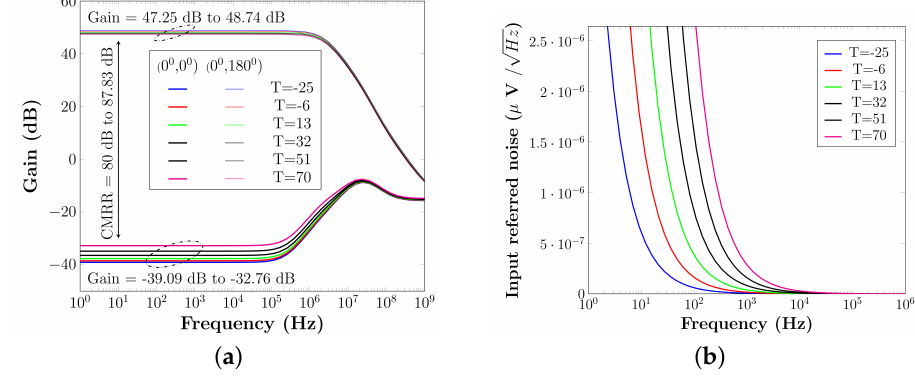
Figure 12. Operational amplifier (Op-Amp) characteristics. ( a ) Op-Amp characteristics respective to temperature. ( b ) Op-Amp noise response respective to